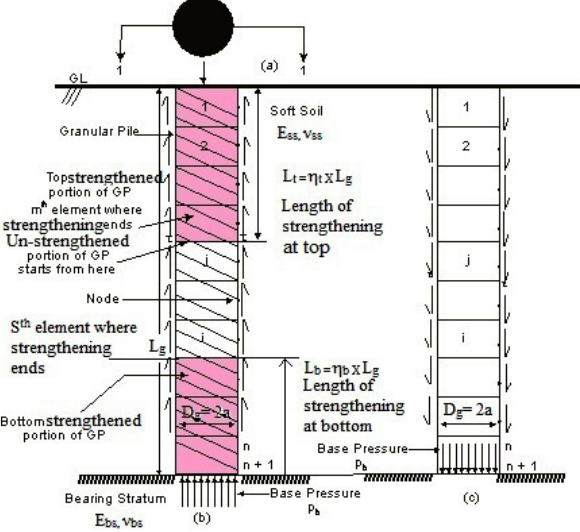
Figure 1: (a) Plan of strengthened end bearing GP (b) Sectional elevation at 1-1 of a single strengthened end bearing GP, subjected to load F, revealing strengthening effect. (c) Problem description sketch, development of interfacial shear stresses on soil due to a single strengthened end-bearing